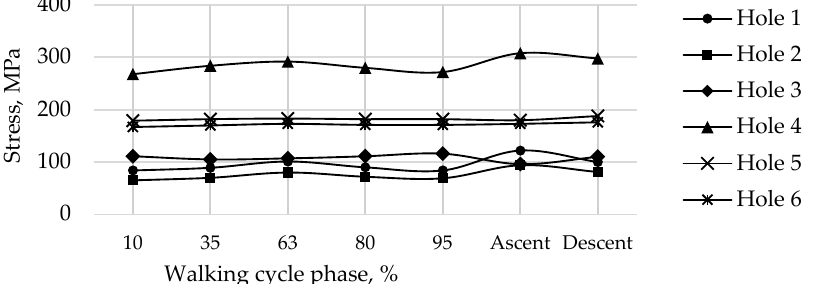
Figure 21. Maximum von Mises stress in the implant at the edges of the holes for a pretension force of 500 N in different phases of the walking cycle.